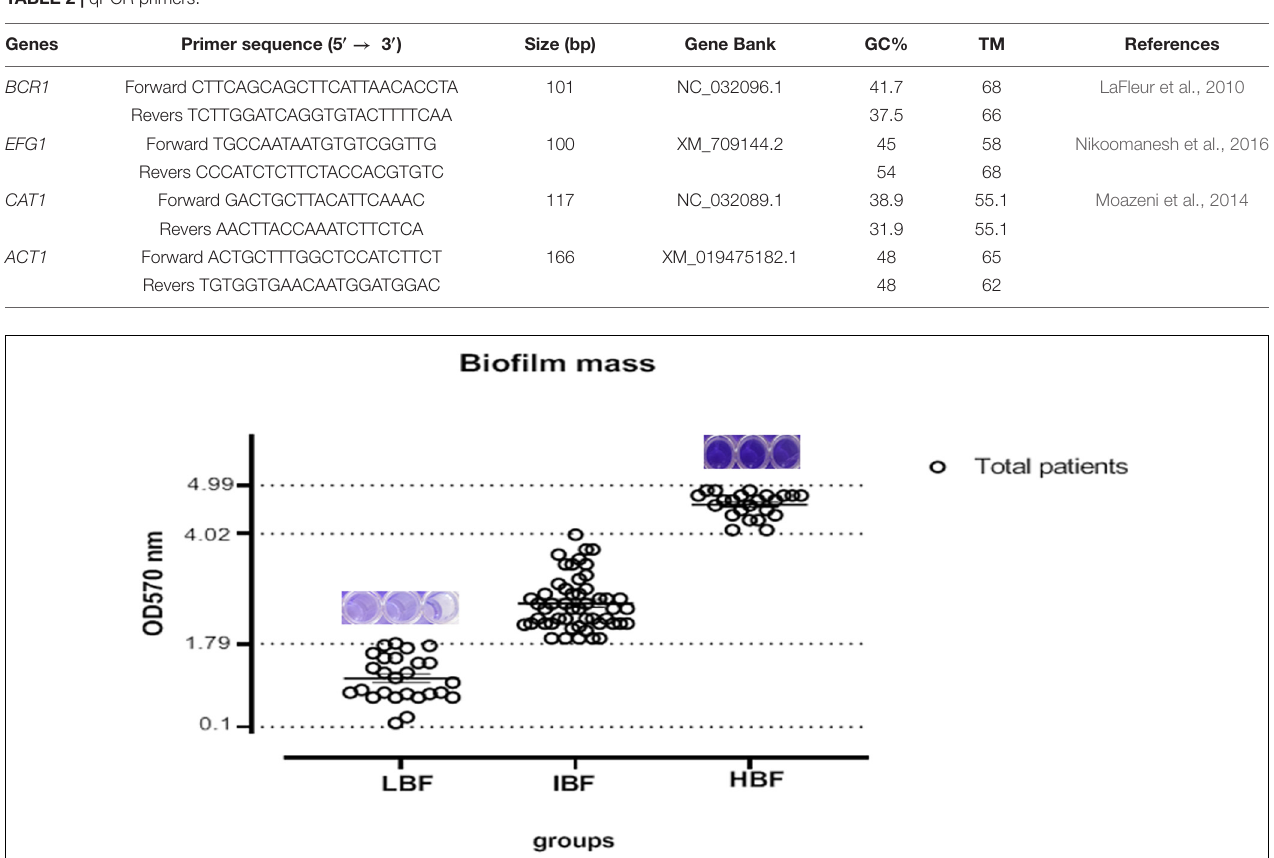
FIGURE 1 | Determination of biofilm production level based on OD quarter; 25% of the isolates had 1.79 ≤ OD (LBF), 50% had 2.5 ≤ OD (IBF), and 75% of the isolates had 4.9 ≤ OD (HBF). LBF, low biofilm formation; IBF, intermediate biofilm formation; HBF, high biofilm